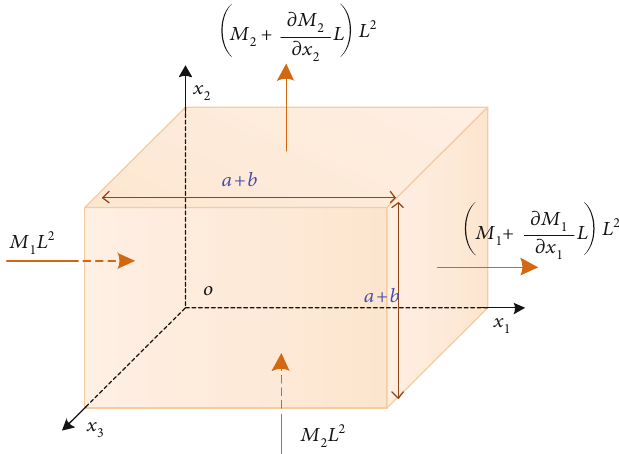
Figure 3: Sketch of a representative element for broken coal.